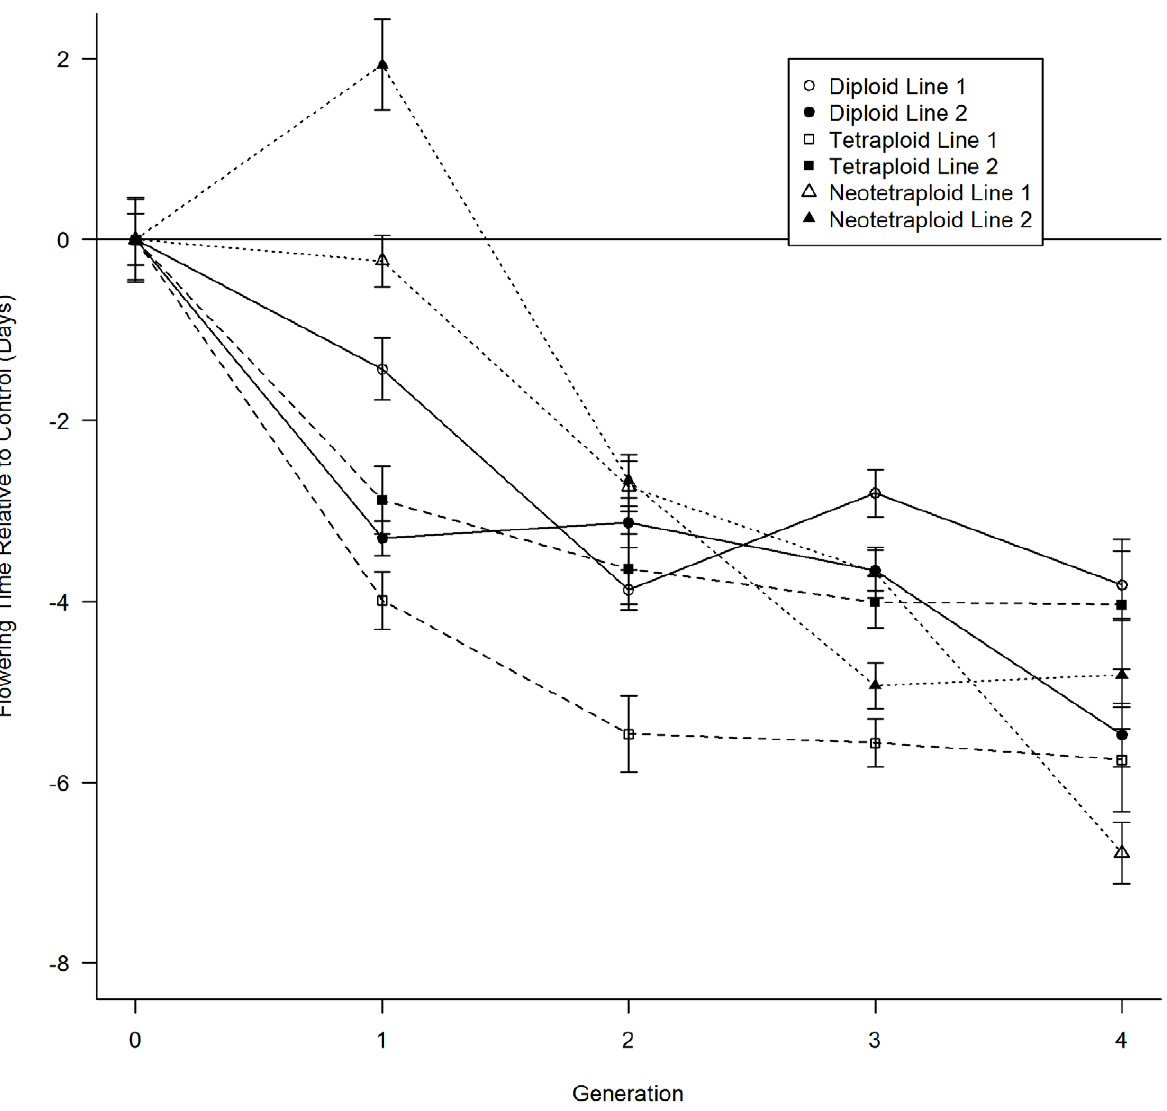
Figure 1. Response to selection for earlier flowering time in diploids, neoautotetaploid and autotetraploid lines. Divergence in flowering time in days relative to the control for diploid, autotetraploid and neoautotetraploid selected lines is shown across the four generations of this experiment. doi:10.1371/journal.pone.0044784.g001 (CV =6.4) lines but nearly half that of tetraploid lines (CV= 12.3). similar to the diploids from which they are derived and the This higher variance in tetraploids is consistent with the expectation that genetic variation in natural populations increases assumption that initial genetic variability in neopolyploids was with gene copy number. Standing variation after four generations